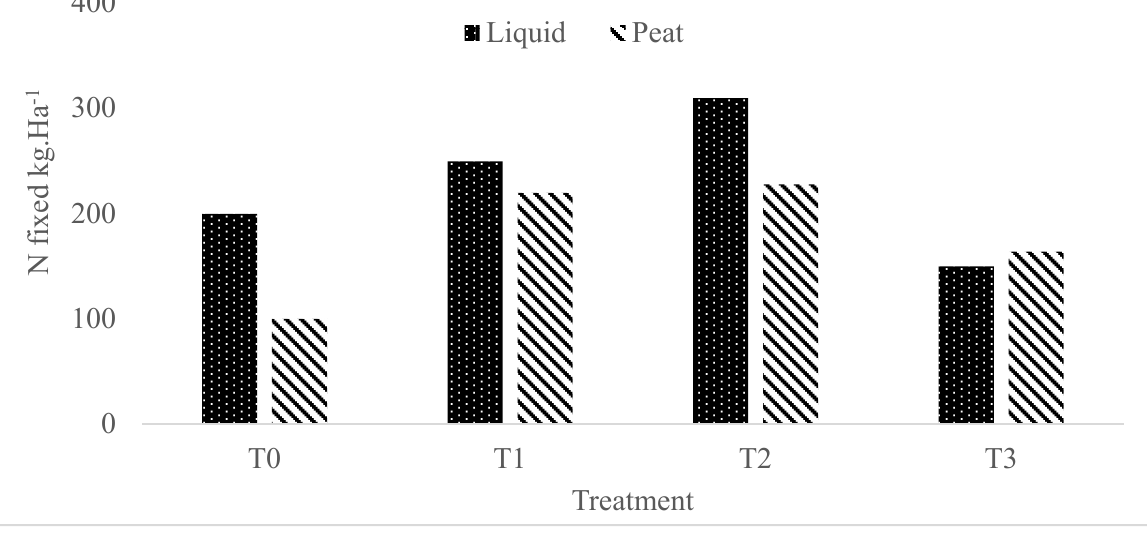
Figure 8. Nitrogen fixed kg ha − 1 of soybean plants subjected to liquid and peat of Bradyrhizobium japonicum inoculum T0 = untreated control, T1 = 150 mL, T2 = 300 and T3 = 150 mL for liquid inoculant and T0 = untreated control, T1 = 250 g, T2 = 500 g and T3 = 150 mL (standard registered) for the peat